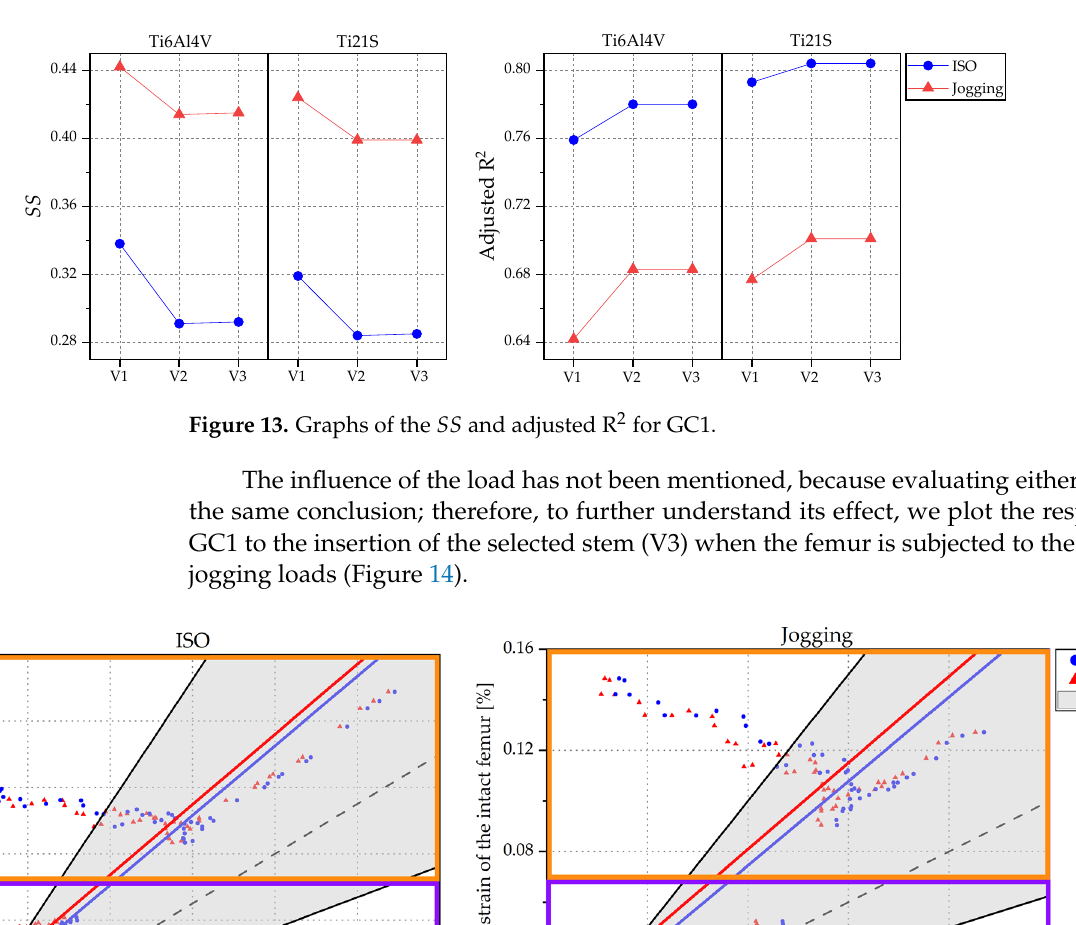
Figure 14. Regression graph of GC1 under ISO and jogging loads.